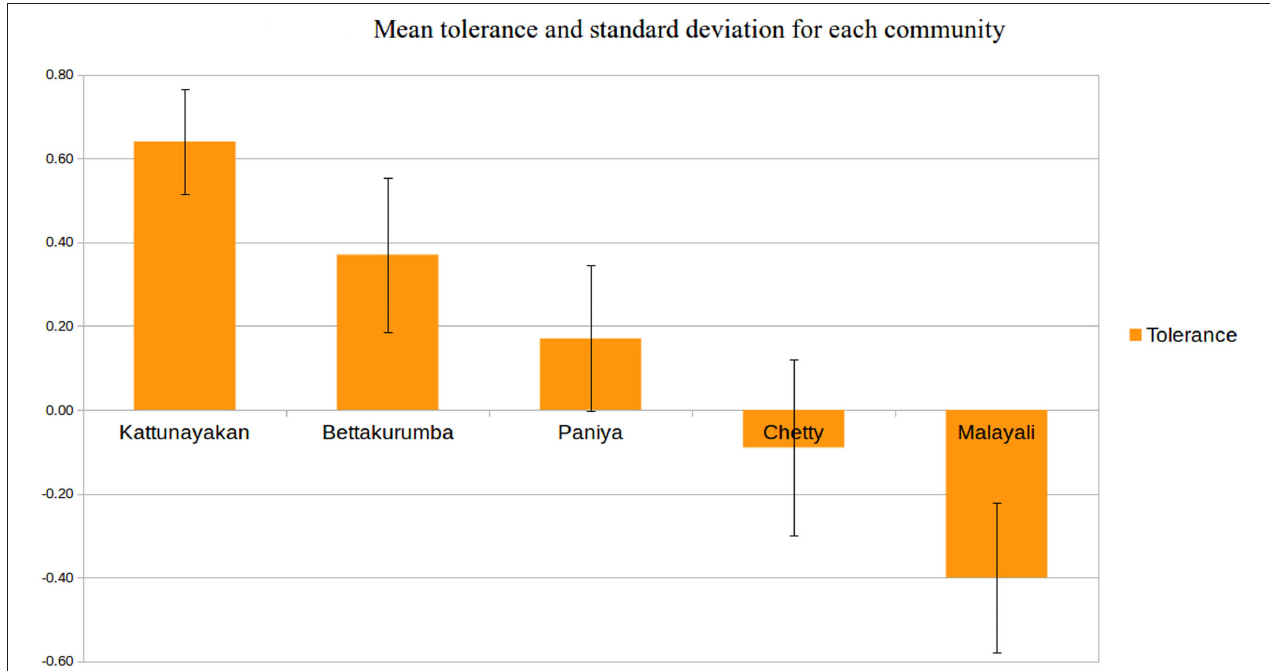
FIGURE 1 | Tolerance across different ethnic communities.